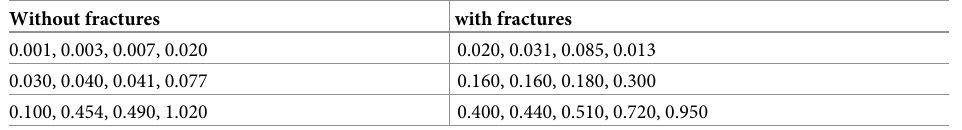
Table 3. Virginia ground water well yields data (in gal/min/ft) [29].